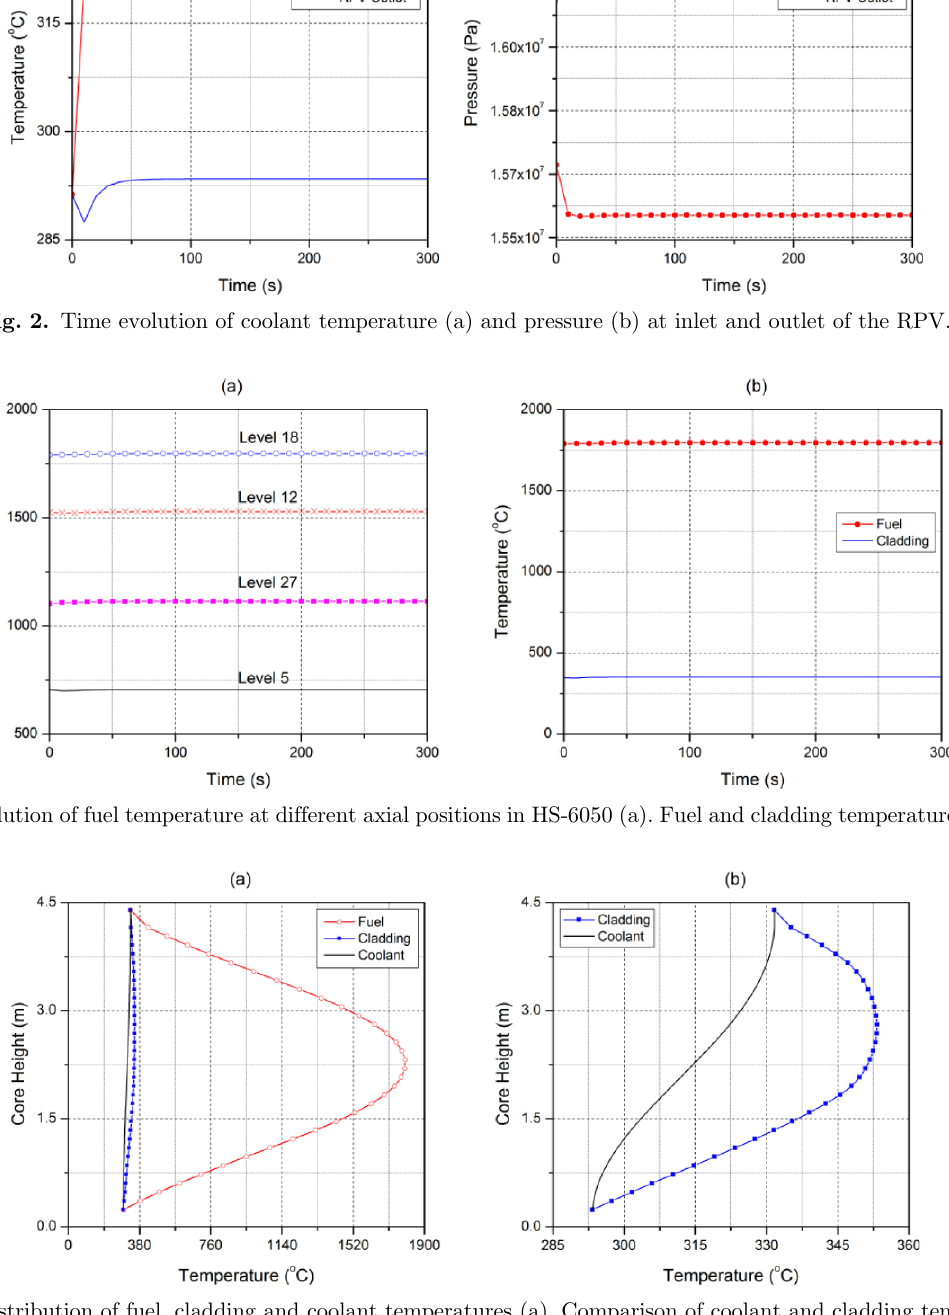
Fig. 4. Axial distribution of fuel, cladding and coolant temperatures (a). Comparison of coolant and cladding temperatures